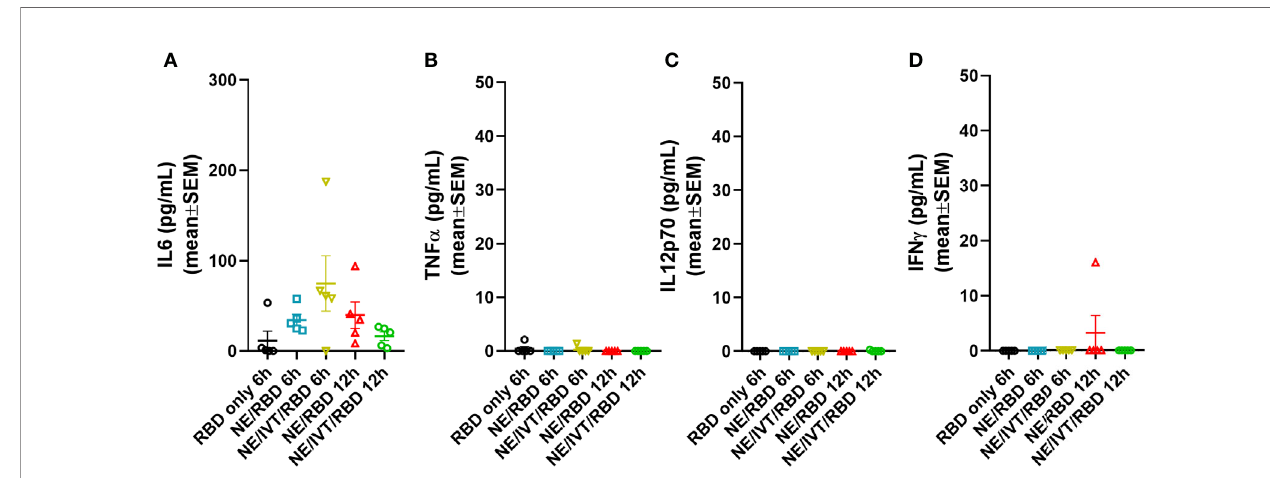
FIGURE 1 | Acute phase cytokine response after immunization with NE and NE/IVT. Acute cytokines were assessed in the serum upon by measuring (A) IL-6, (B) TNF- a , (C) IL12p70, and (D) IFN- g by multiplex immunoassay at 6 and 12 h post-IN immunization with 10 m g of RBD only, or with 20% NE, or 20% NE/0.5 m g IVT DI.